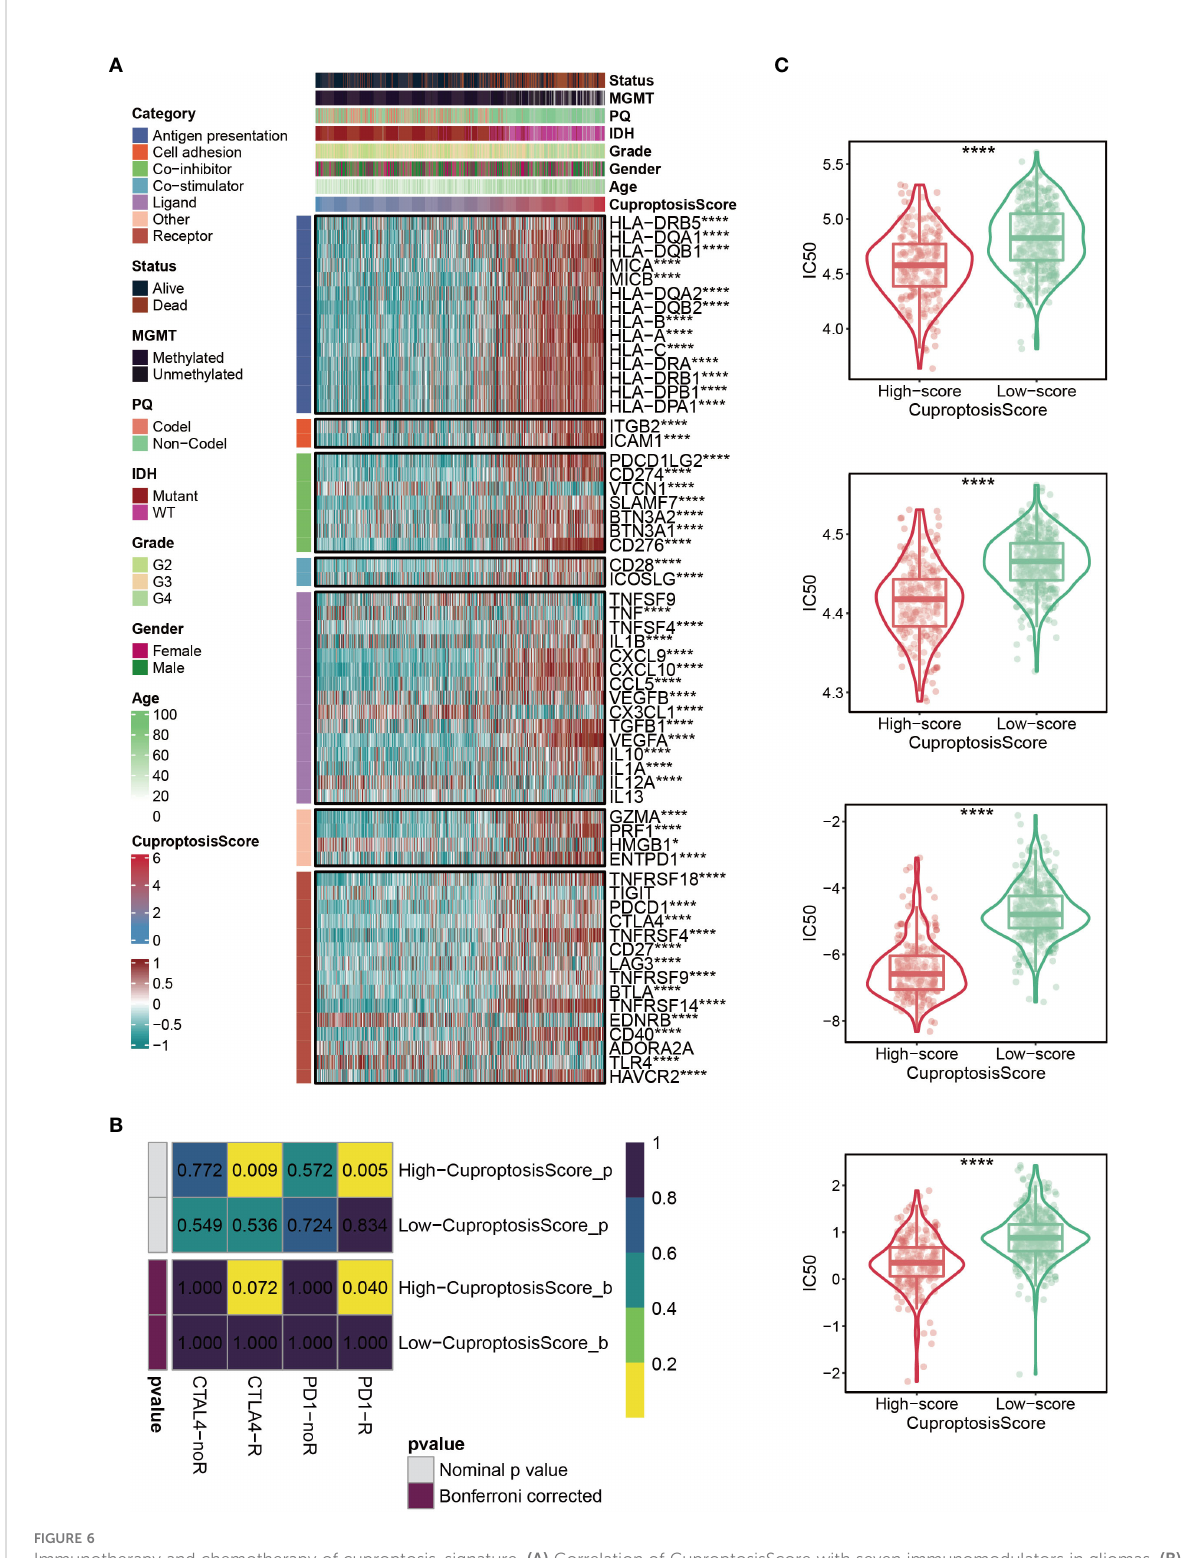
FIGURE 6 Immunotherapy and chemotherapy of cuproptosis-signature. (A) Correlation of CuproptosisScore with seven immunomodulators in gliomas. (B) SubMap analysis for cuproptosis-signature in gliomas. (C) Box plots of estimated IC50 for several chemotherapeutic agents in the high- or low- CuproptosisScore groups. *P < 0.05; **P < 0.01; ***P < 0.001, ****P <